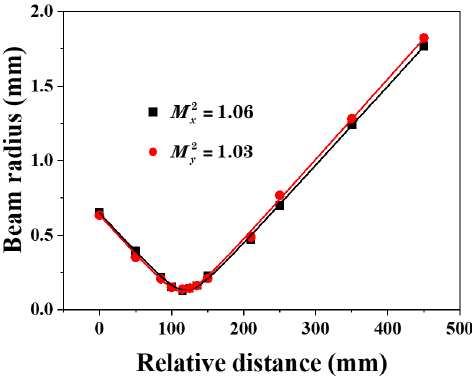
Figure 6. Spectrum of the Tm:YAG ‐ Ho:GdVO 4 laser. Measurement results of the M 2 of the intra ‐ cavity Ho:GdVO 4 laser are shown in Figure 7. Under the strongest output of 1.6 W, M 2 factors could reach 1.06 (x direction) and 1.03 (y direction), which meant that the output laser beam was close to the diffraction Figure 7. M 2 measurement of the Tm:YAG ‐ Ho:GdVO 4 laser. Figure 7. M 2 measurement of the Tm:YAG-Ho:GdVO 4 limit.